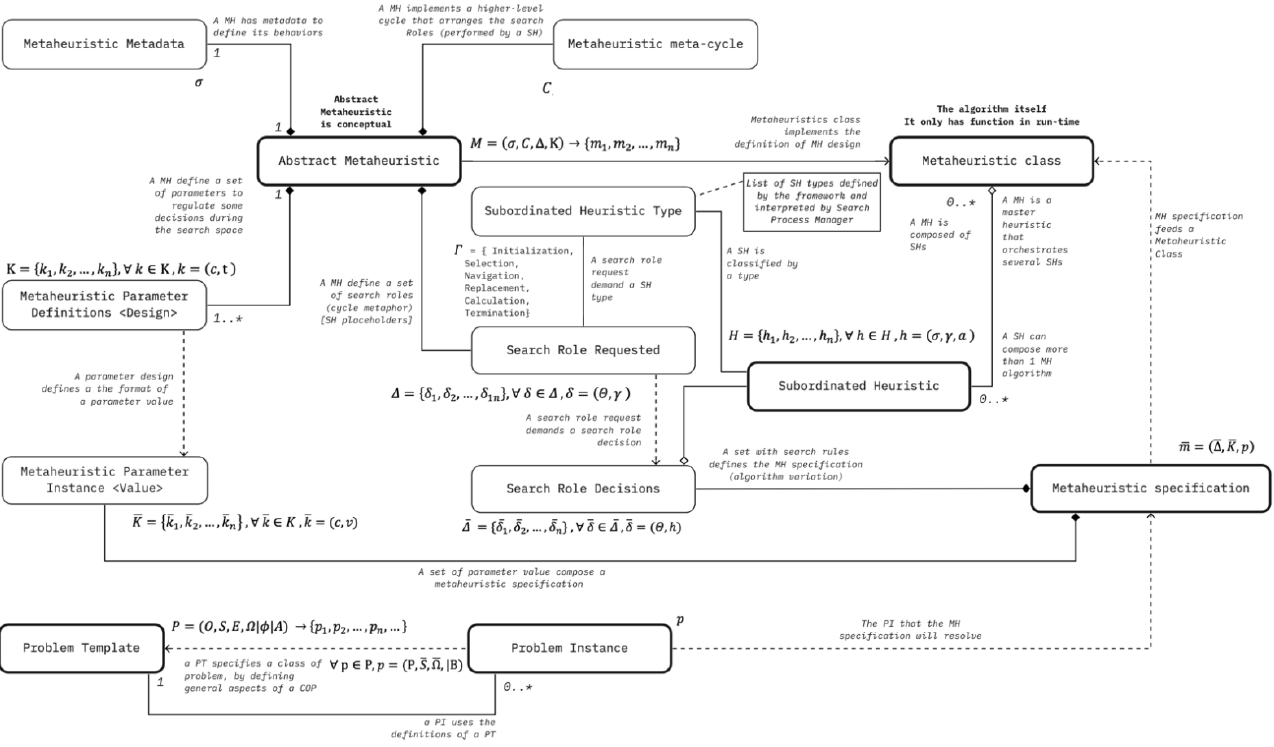
Figure 8. Metaheuristic definitions.